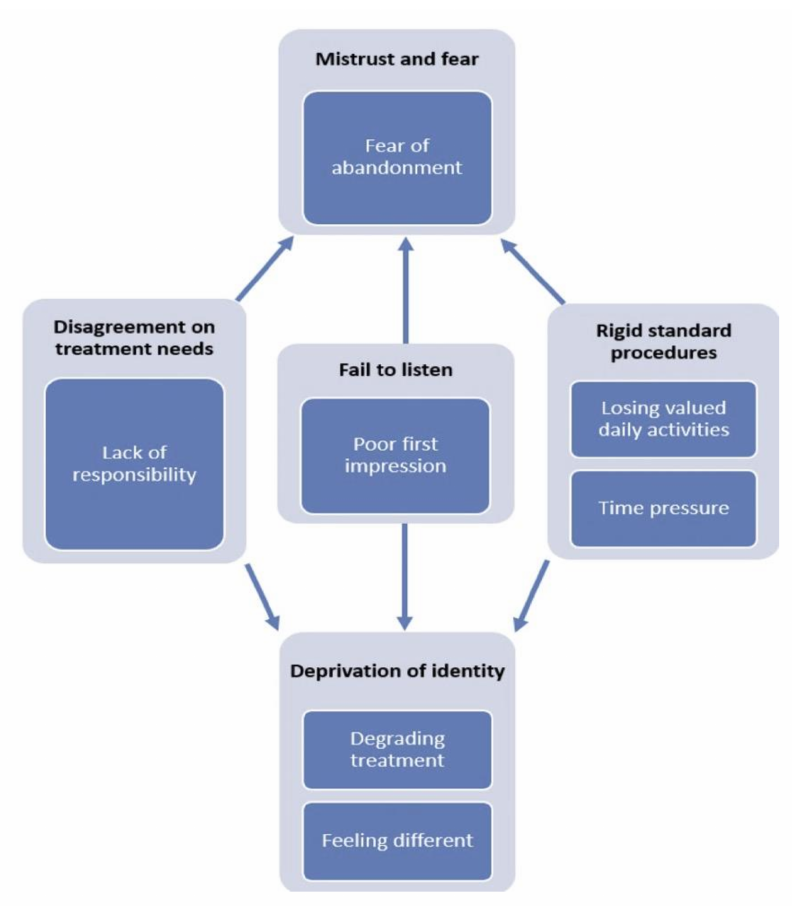
Figure 1. Thematic map of main